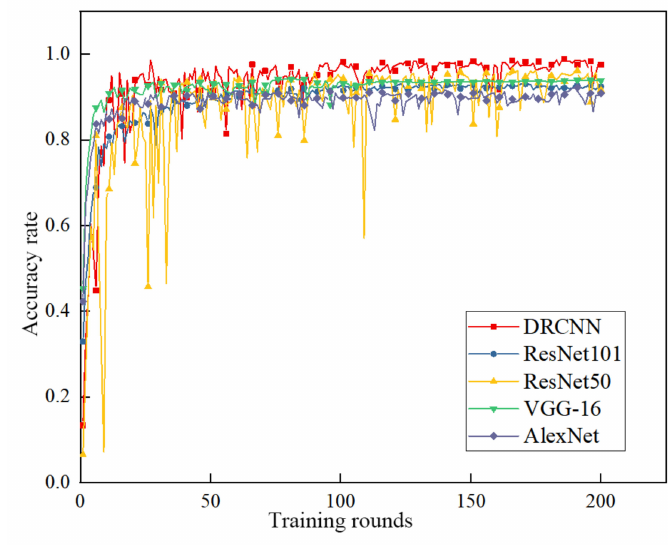
Figure 9. Training accuracy.